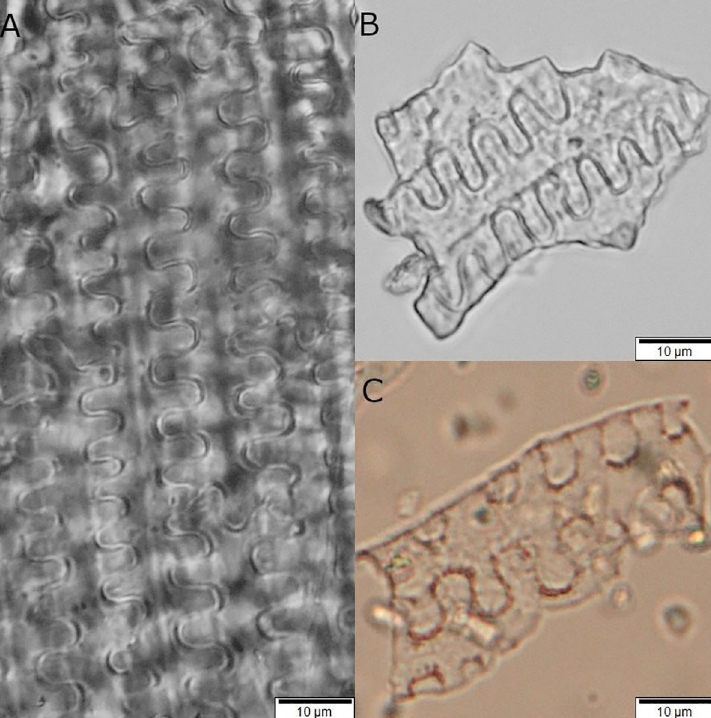
Fig 10. Phytolith examples of long cells with Ո ornamentation. A) Modern upper lema S . verticillata ; B-C) Archaeological examples recovered in this study. Pictures at 40x magnification.